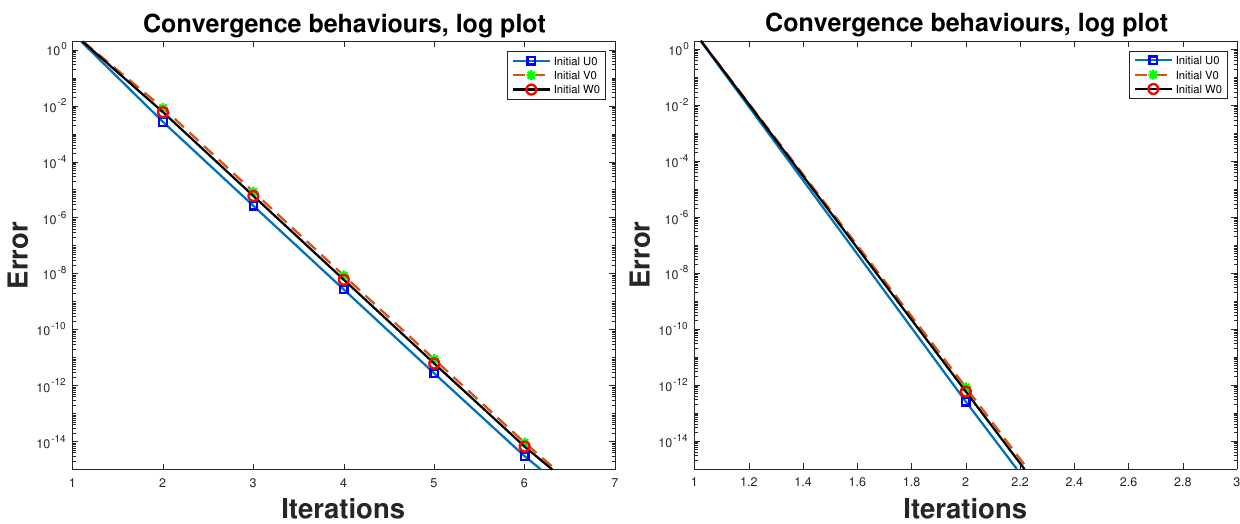
Figure 3. Convergence behavior for b = 0 ( left ) and b = 10 10 ( right